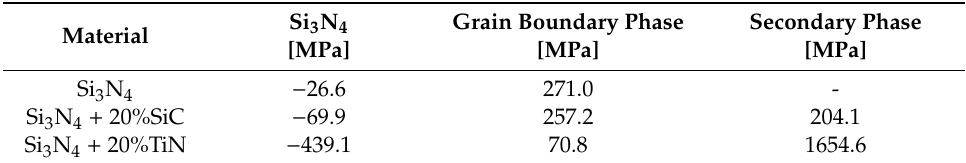
Table 5. Average residual stresses in silicon nitride-based materials: finite element method (FEM) simulation.